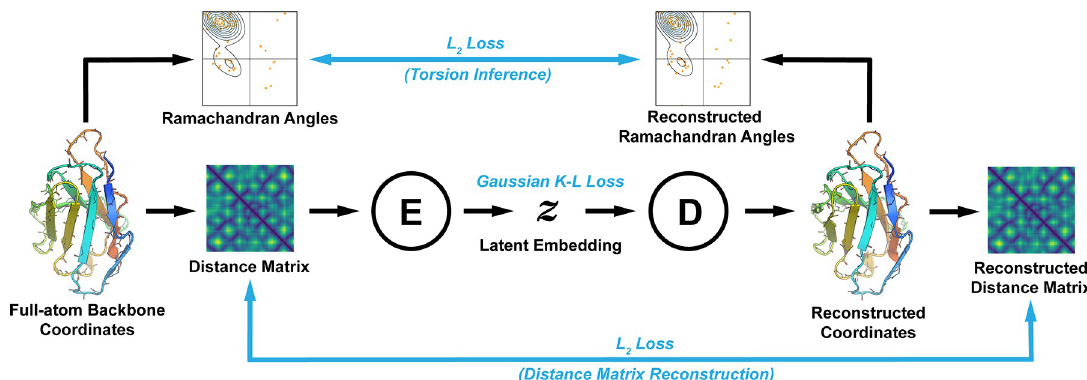
Fig 1. VAE Training Scheme. The flow of data is shown with black arrows, and losses are shown in blue. First, Ramachandran angles and distance matrices are computed from the full-atom backbone coordinates of a training example. The distance matrix is passed to the encoder network (E), which generates a latent embedding that is passed to the decoder network (D). The decoder directly generates coordinates in 3D space, from which the reconstructed Ramachandran angles and distance matrix are computed. Errors from both the angles and distance matrix are back-propagated through the 3D coordinate representation to the encoder and decoder. Note that both the torsion and distance matrix losses are rotationally and translationally invariant, and that the coordinates of the training example are never seen by the model. The shown data are real inputs and outputs of the VAE for the immunoglobulin chain in PDB:4YXH(L).